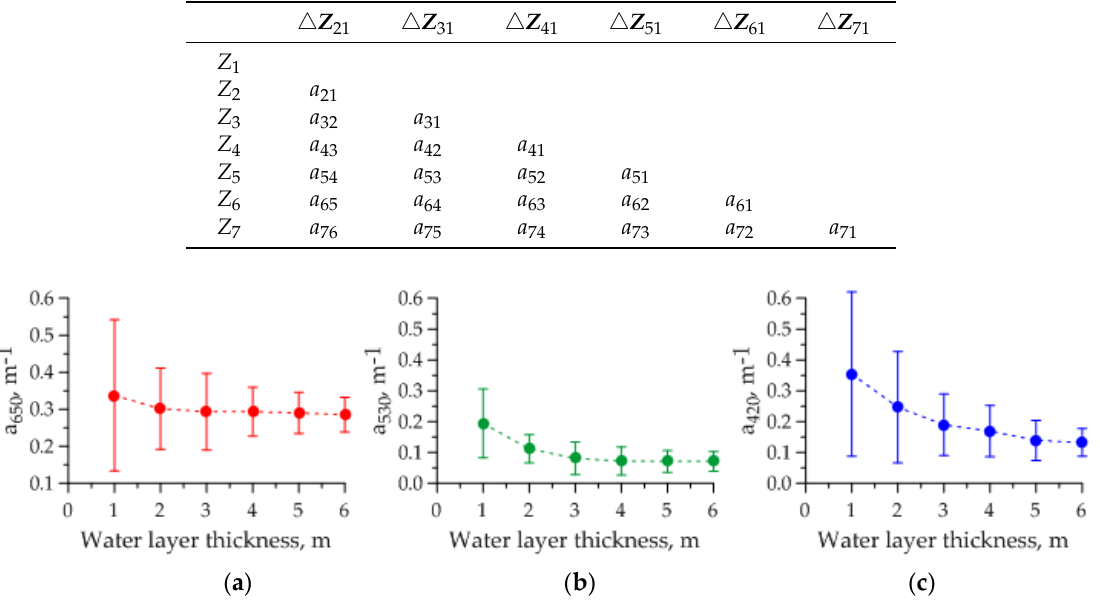
Table 3. The quantity of recovered absorption coefficient for a full depth pass as a function of the depth step.